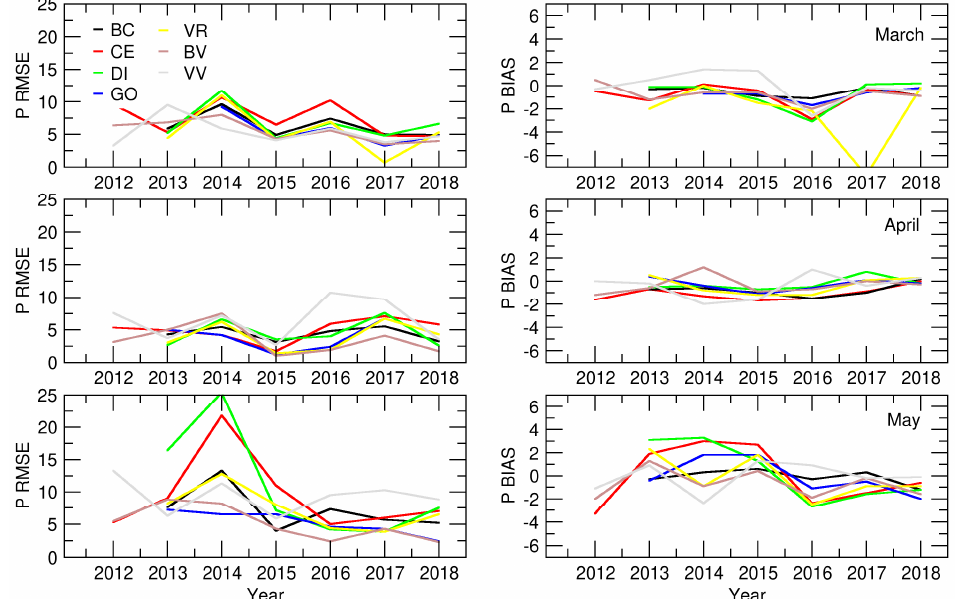
Figure 5. Daily precipitation RMSE (mm) and BIAS (mm) for selected locations during MAM 2012–2018.